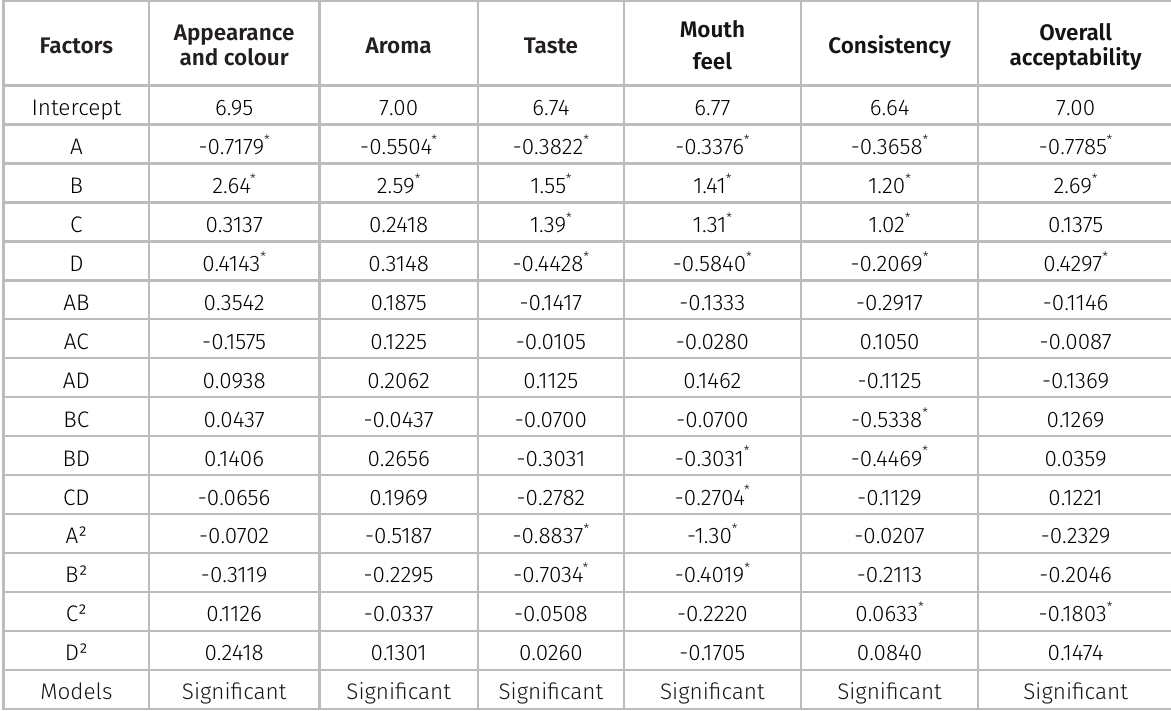
Table III. Coefficient estimates of sensory properties for microgreen based functional